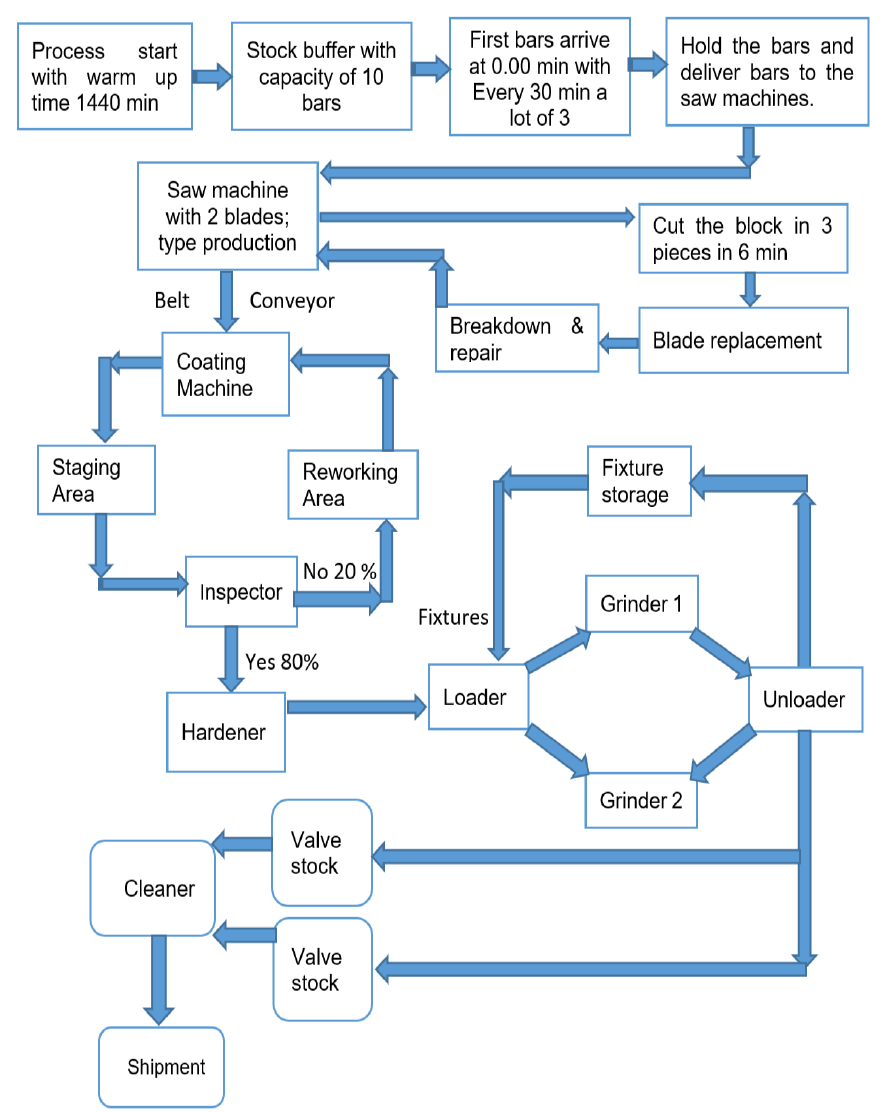
Figure 10. Data-driven process identification model.